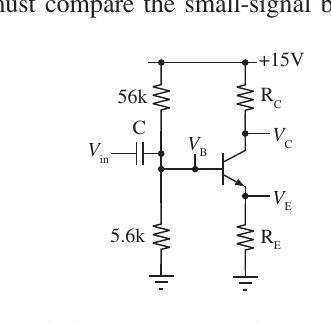
FIG. 2. Canonical BJT common-emitter amplifier circuit used in the three amplifier comparison task. The base ( V B ), collector ( V C ), and emitter ( V E ) voltages have been labeled for